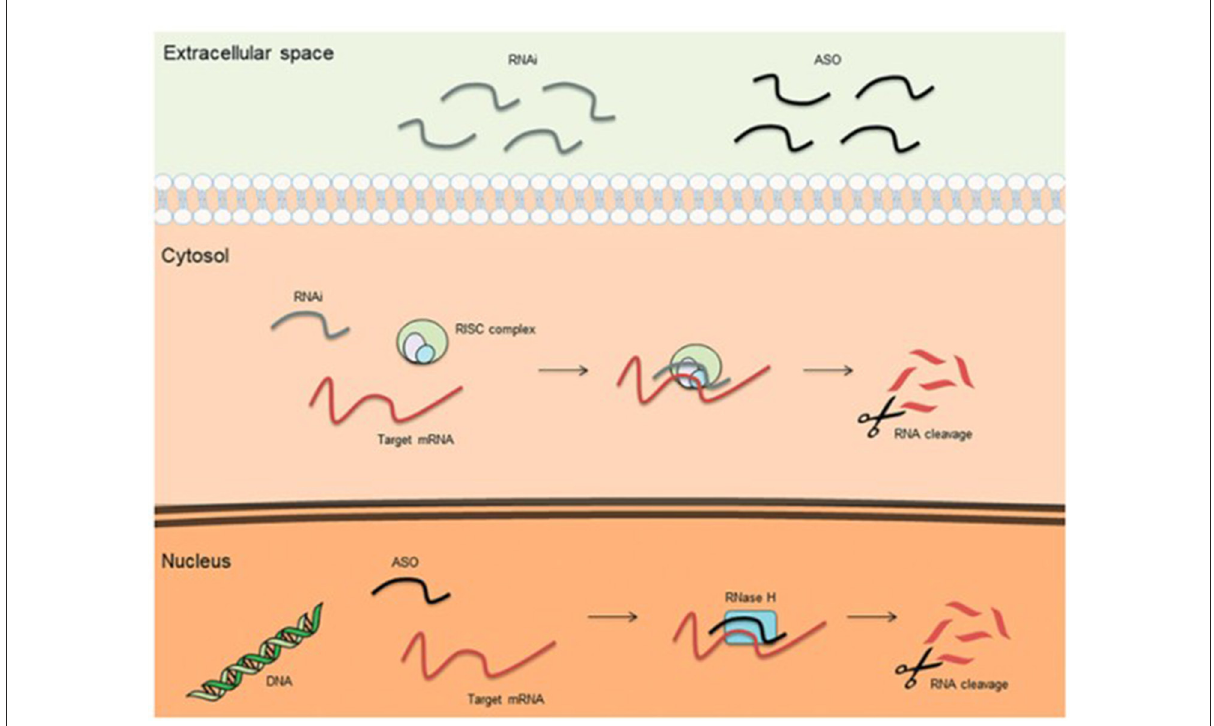
FIGURE1 Basic mechanisms of action for therapeutic antisense oligonucleotides (ASOs) and RNA interference (RNAi) (38).